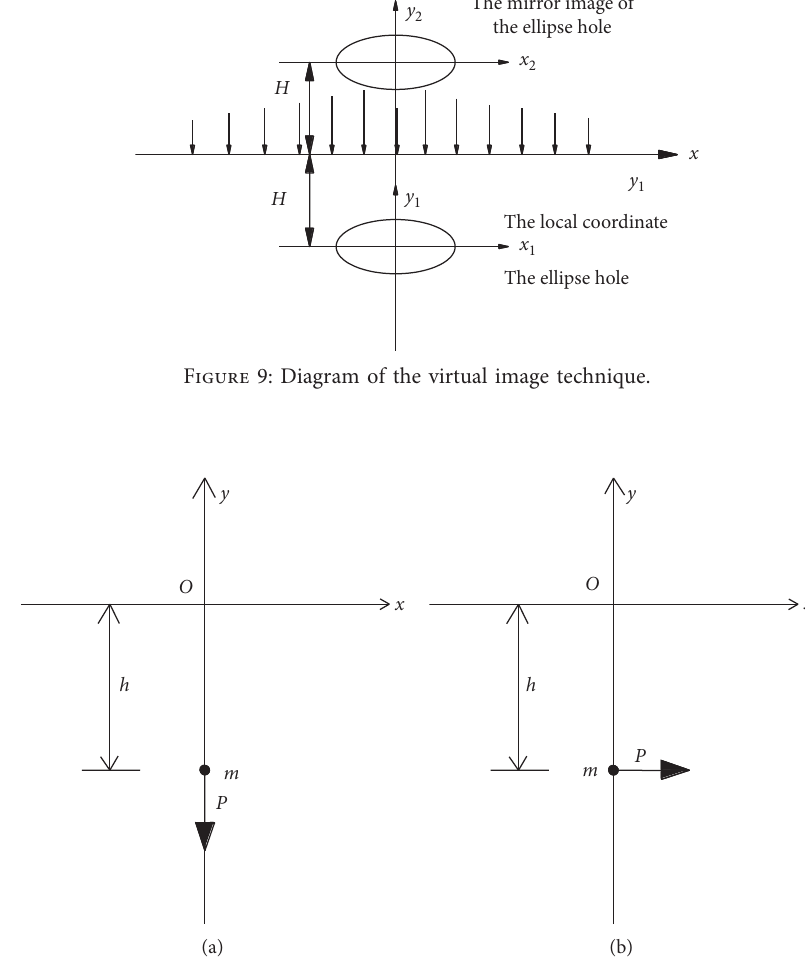
Figure 10: Schematic diagram of the vertical and horizontal concentrated forces applied to the half-plane.